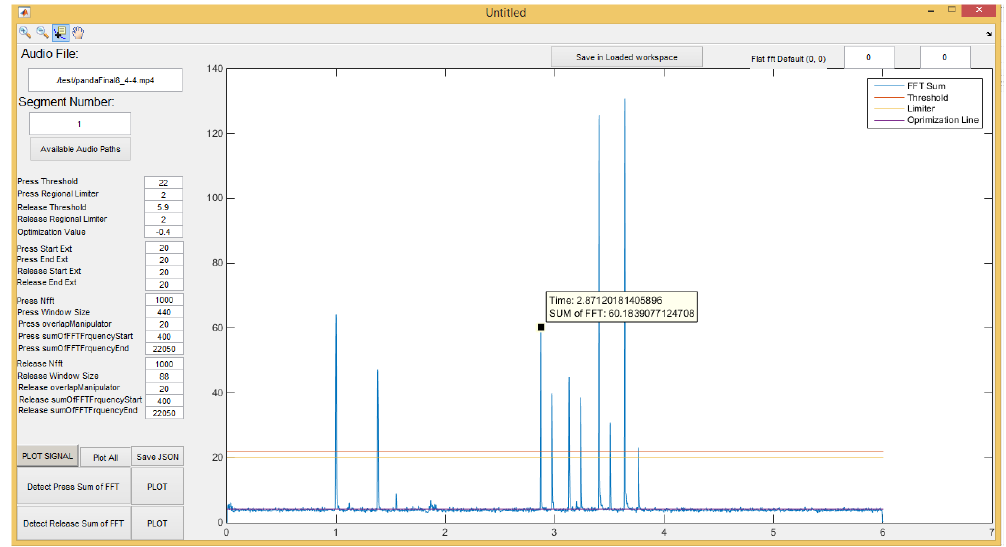
Figure 6. Sum of FFT coefficients to detect Key Pres.